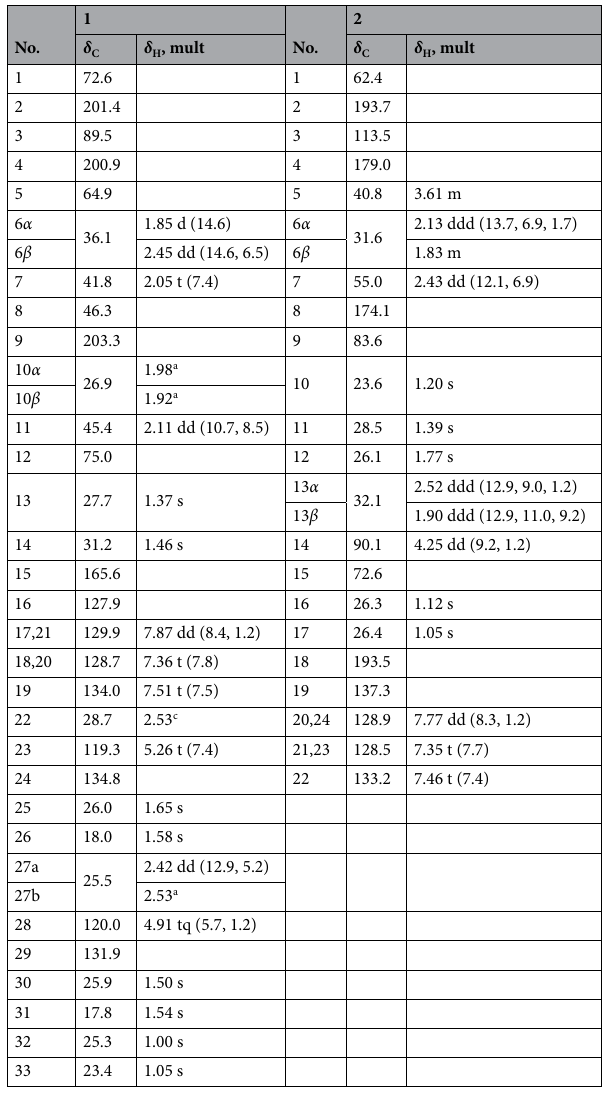
Table 1. 1 H and 13 C NMR data (CDCl 3 ) of 1 ( 1 H (500 MHz) and 13 C (125 MHz)) and 2 ( 1 H (600 MHz) and 13 C (150 MHz).) ( δ in ppm, J in Hz). a Overlapping